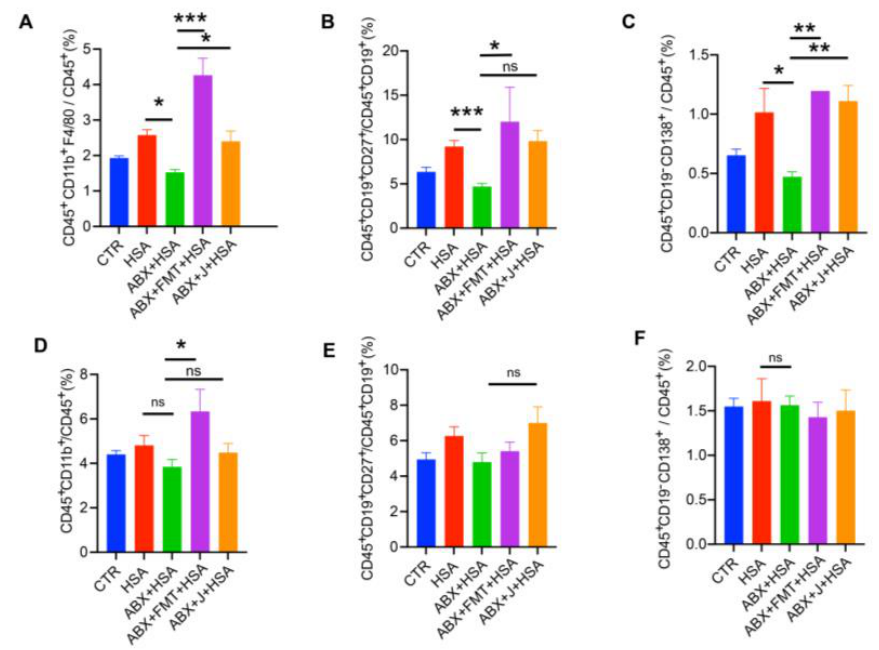
Figure 2. FMT and jujube powder enhanced macrophages, plasma cells, and memory B cells of HSA-vaccinated mice. ( A – D ) The proportions of macrophages, memory B cells, plasma cells, and myeloid cells in the MLNs. ( E , F ) The proportions of memory B cells and plasma cells in the spleen. no significance (ns), p > 0.05, * p < 0.05, ** p < 0.01, *** p < 0.001.